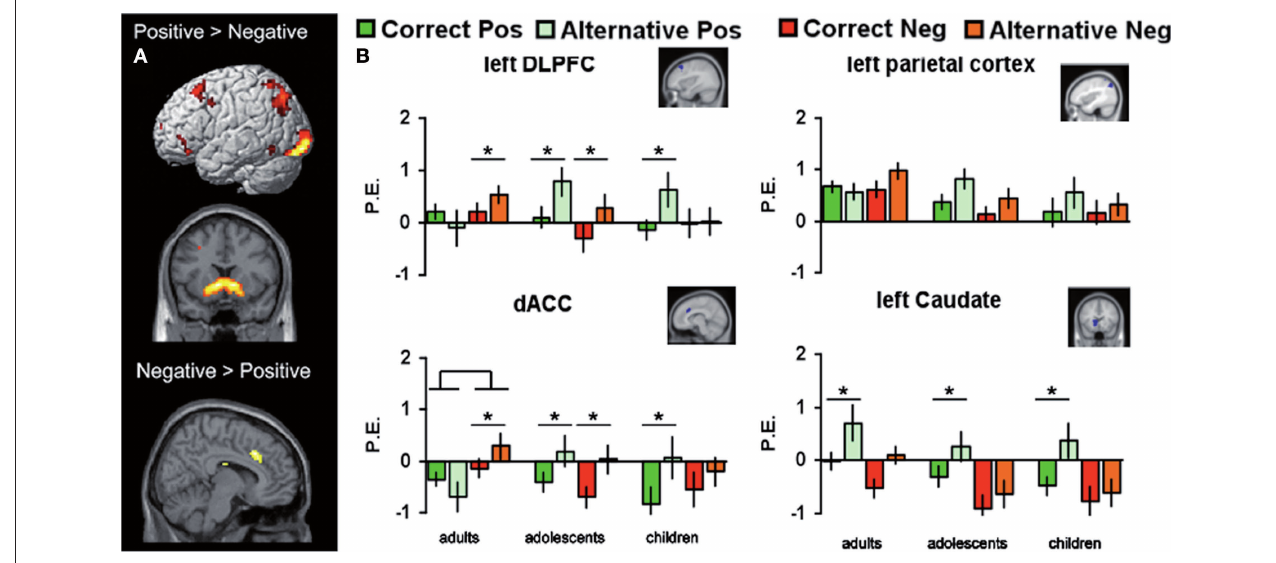
displayed for each age group in left DLPFC, left parietal cortex, dACC and left caudate. Signifi cant differences between brain activity in two conditions are indicated with an asterisk (*Bonferroni corrected).